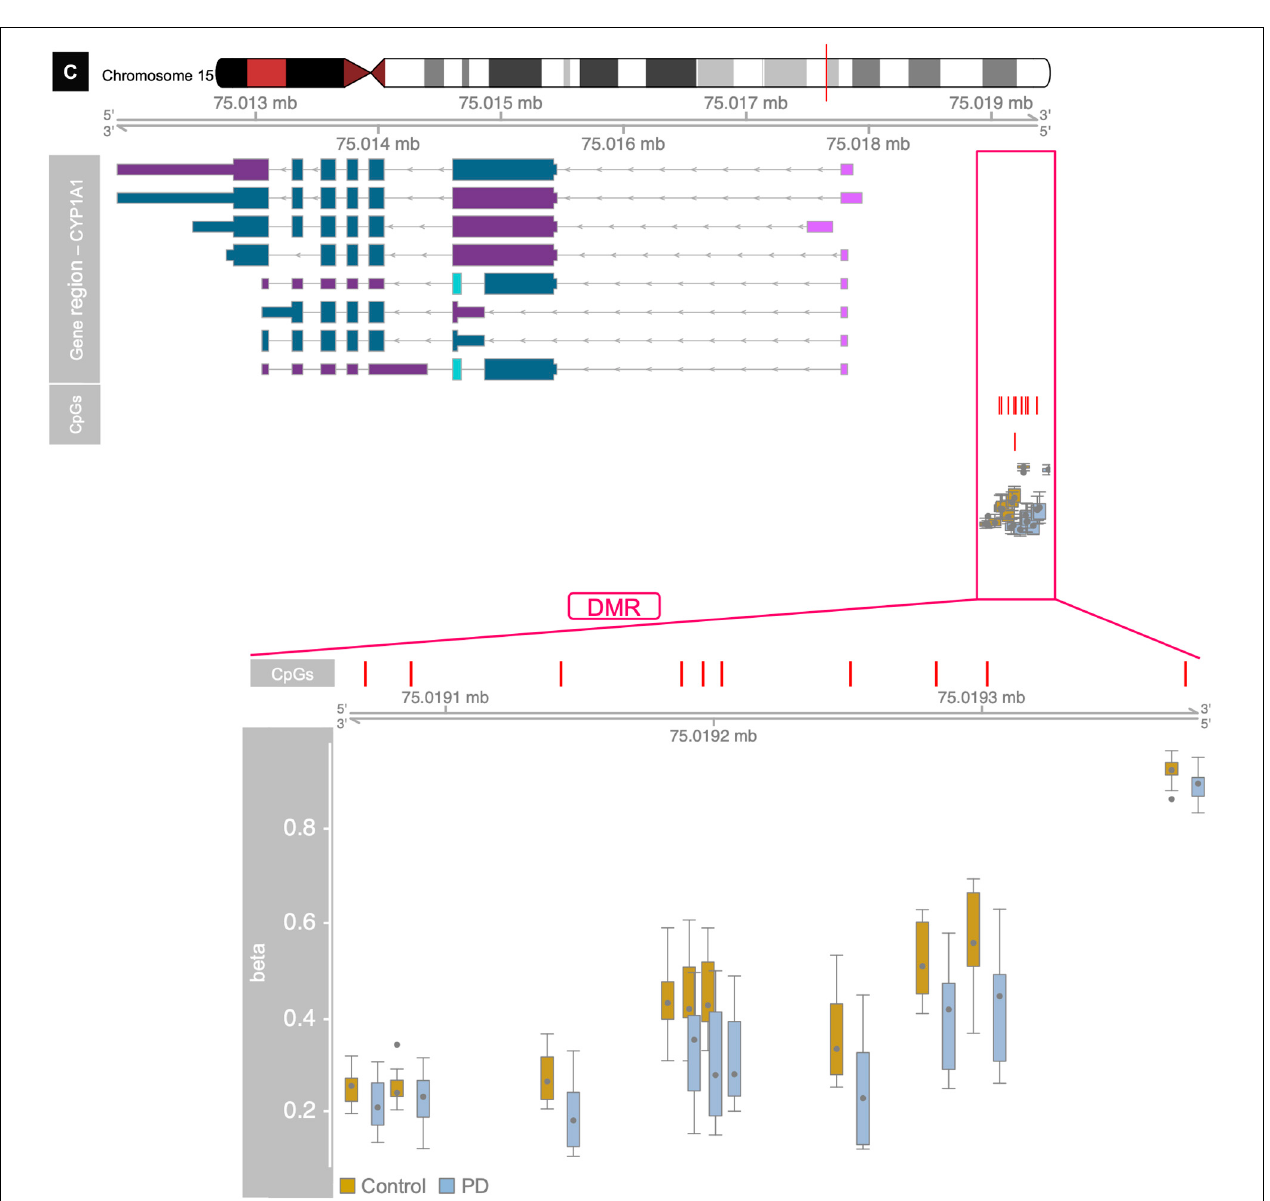
( Table 5 ): C-type lectin domain containing 11A ( CLEC11A ), signal-induced proliferation-associated 1, like 2 ( SIPA1L2 ), ribosomal protein L29 ( RPL29 pseudogene/AL450405.1), and